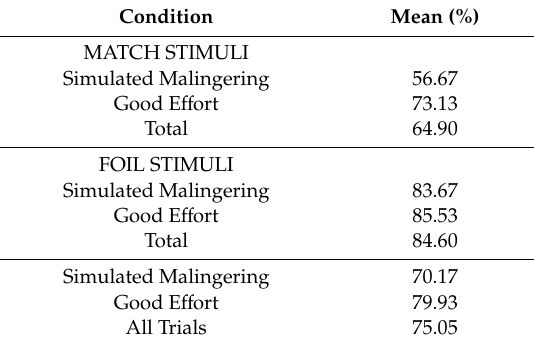
Table 3. Group Comparison of Mean Accuracy for Experiment 2 ( N = 15).